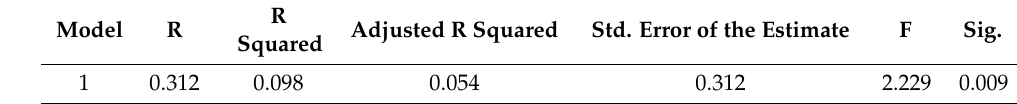
Table 8. Model summary (restoration